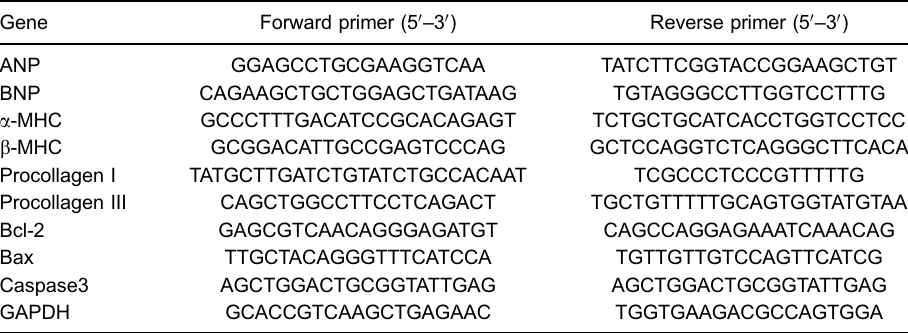
Table 1. Primers used in the